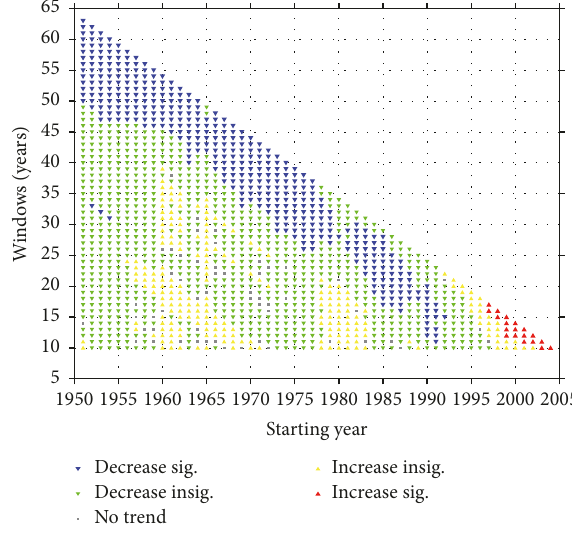
Figure 5: Running trends of annual mean regional series in the 12- month